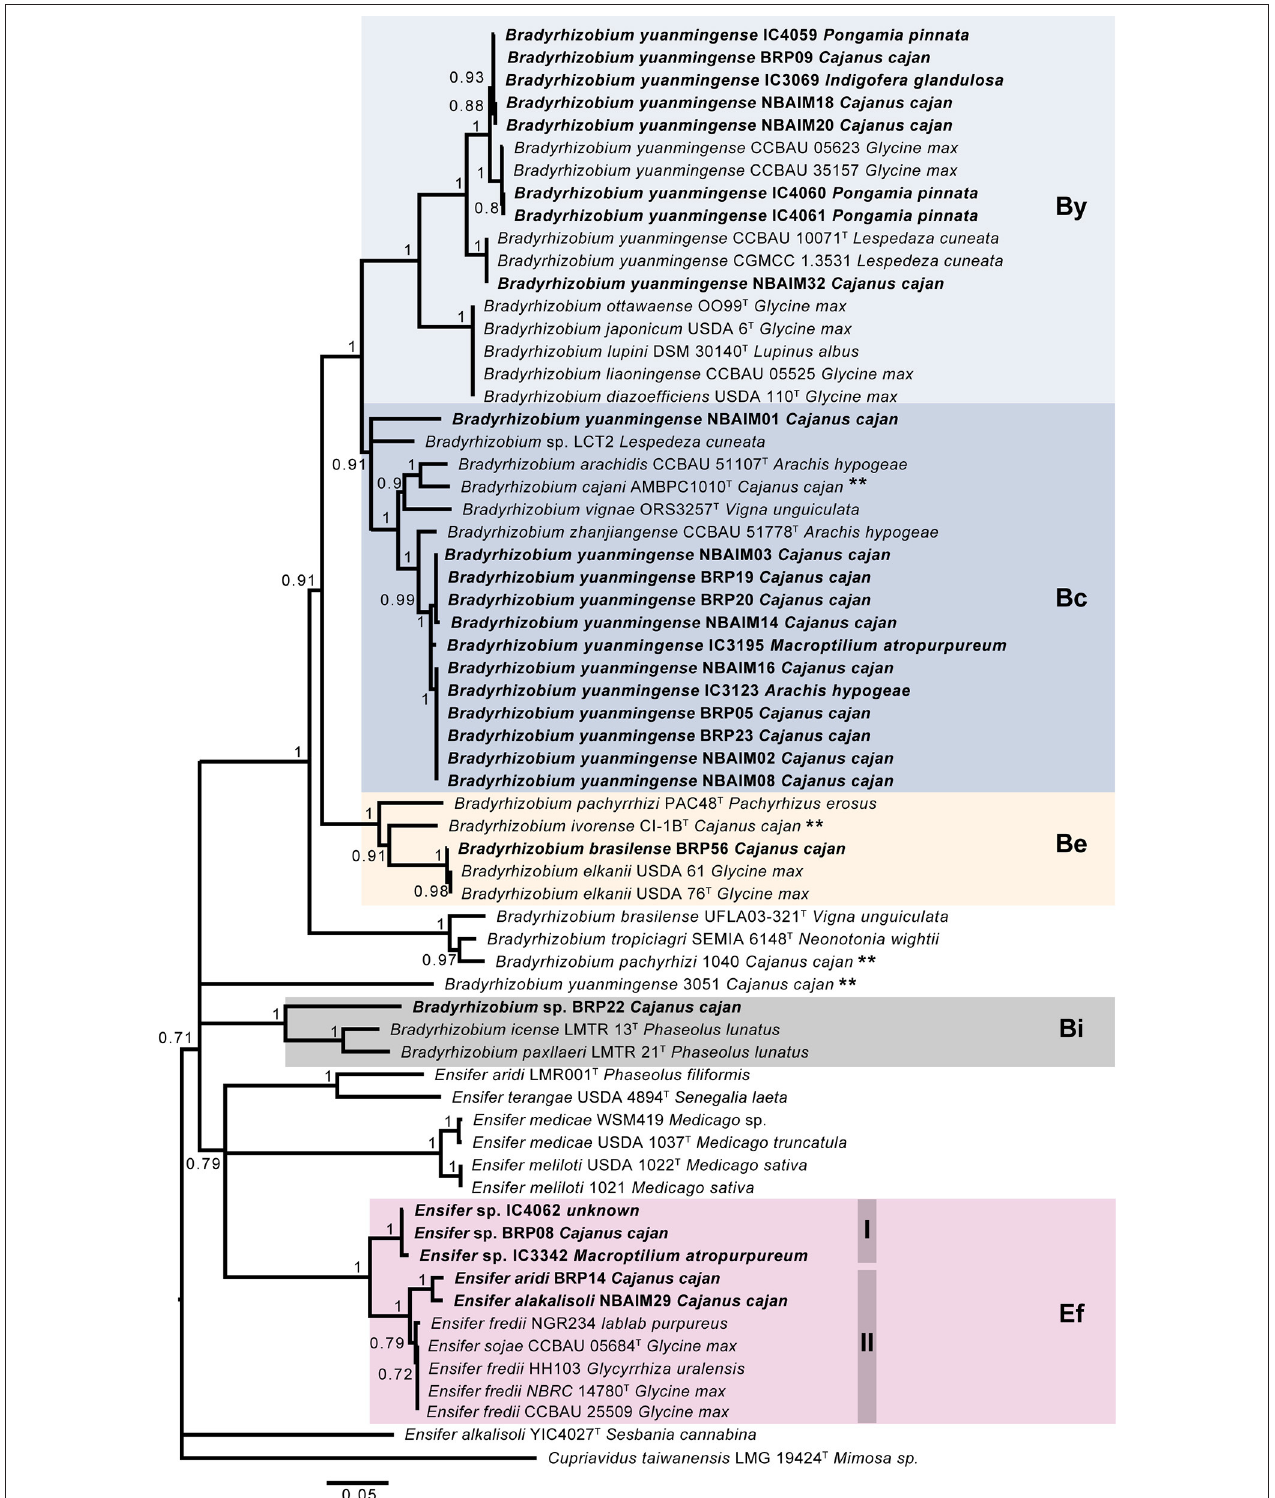
FIGURE 4 | Tree-based on nodC phylogeny. Neighbour-joining (NJ) phylogenetic tree based on nodC sequence (1,458 nt) of IU and IC strains with closely related species. Each is shown together with the plant from which it was isolated. Bootstrap values (only values > 70%, expressed as a percentage of 1,000 replications) are shown at the branching points. Bar, 5 nt substitutions per 100 nt. **Strains isolated from C. cajan . By ( B. yuanmingense ), Bc ( B. cajani ), Be ( B. elkanii ), Bi ( B. icense ), and Ef ( E. fredii ).